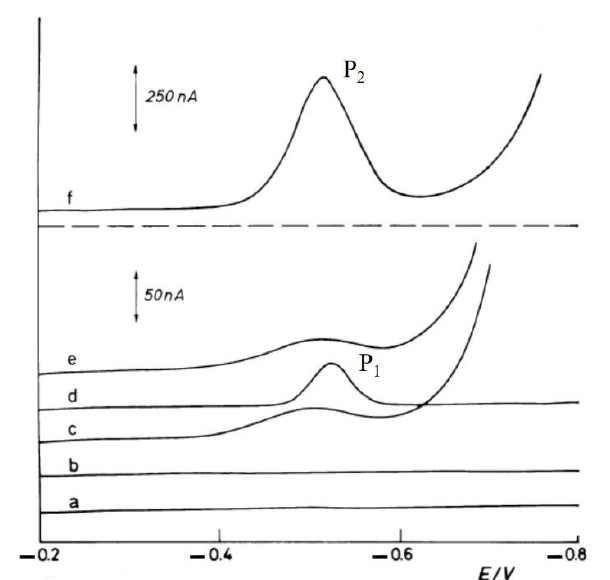
Figure 5. DP voltammograms recorded in a solution containing 1 mM of HClO 4 + 0.1 M of NaClO 4 (pH 2.9) and: (a) 0.2 mM of Ge(IV); (b) 0.01 mM of catechol; (c) 2 mM of V(IV); (d) 0.01 mM of Ge(IV) + 3 mM of V(IV) (P 2 ). E acc = − 0.2 V; t acc = 5s. Reprinted with permission from ref. [39].